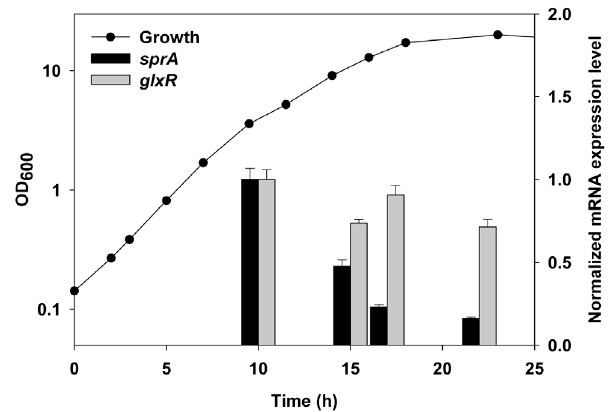
Figure 2. Expression of glxR and sprA during growth. Cells were grown in glucose MCGC media, and mRNA levels were measured by RT- qPCR as described in the Materials and Methods. The data represent three independent experiments. Filled circles indicate the growth of C. glutamicum . Bars indicate mRNA levels of glxR (grey) and sprA (black), respectively. OD, optical density.